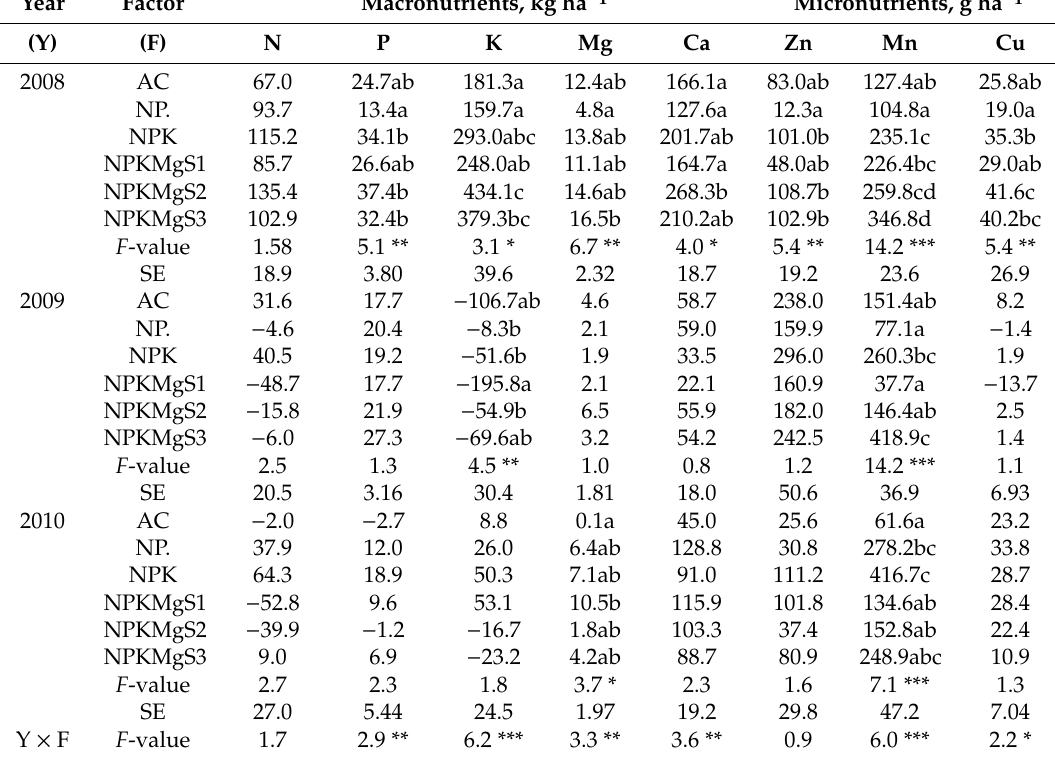
Table 8. Post-flowering nutrient uptake by WOSR